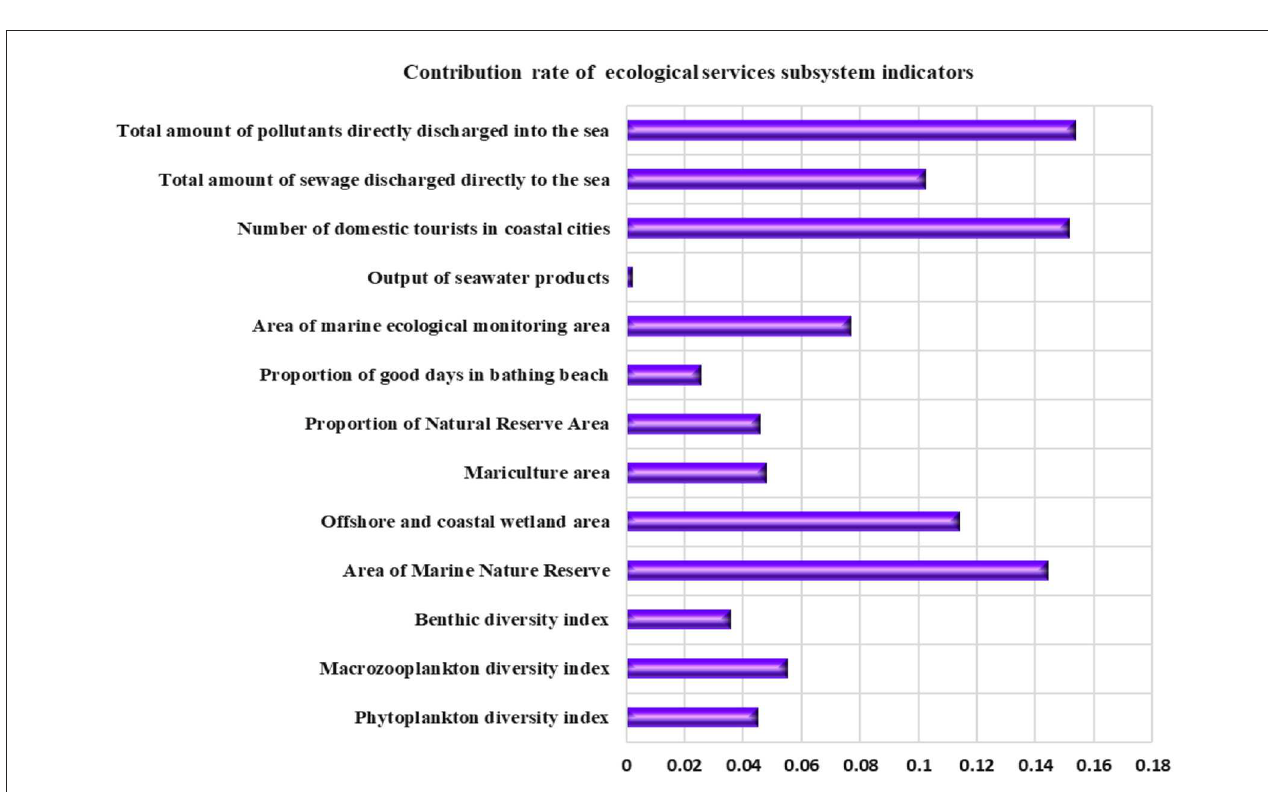
FIGURE7 Index contribution rate of coastal ecological service subsystem in Shandong